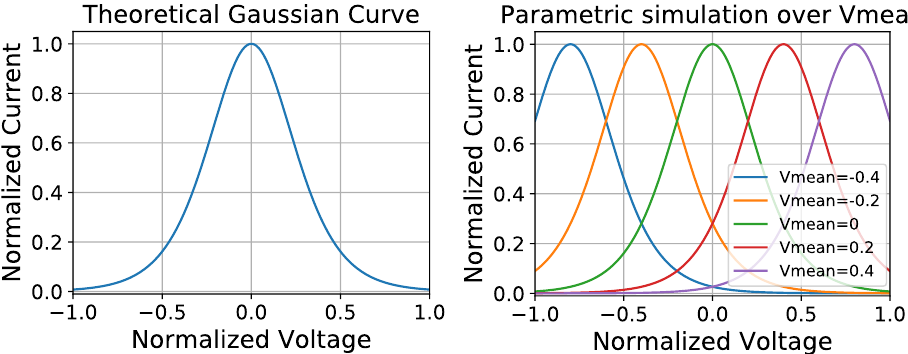
Figure 4. Theoretical output current of Delbruck’s Simple Bump ( left ) Simulation for V mean = 0 ( right ) Parametric simulation over V mean